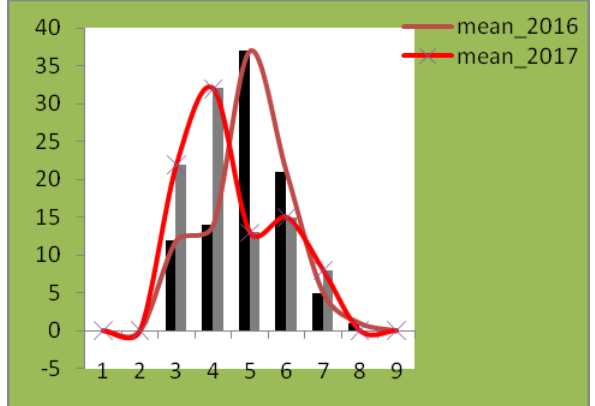
Figure 4: Mean backscatter data distribution for both seasons